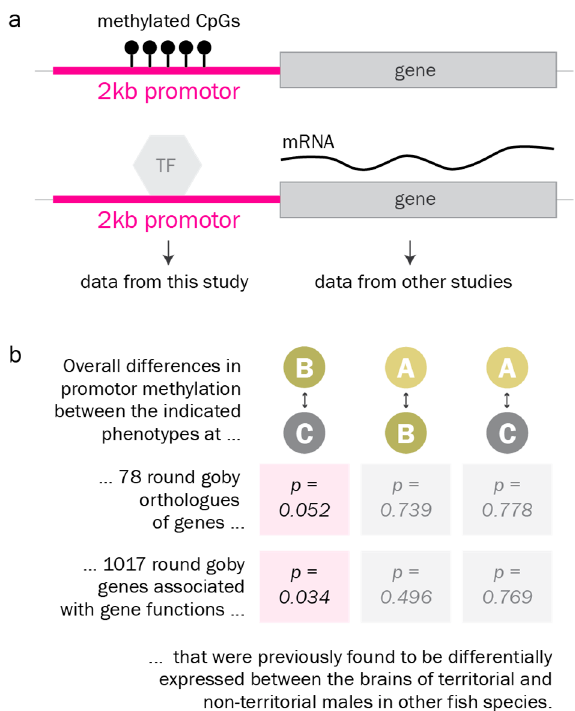
Figure 6. Promoter methylation of candidate genes. a. Promoter DNA methylation (balls on a stick) has been reported to regulate gene expression, for example by preventing transcription factors (TF) from binding to the promotor. b. According to Gene Set Enrichment analysis, promoters of candidate genes associated with reproductive phenotypes in fish in the literature (Table S3) are significantly more often differentially methylated between the territorial and the non-territorial phenotype than the average gene.